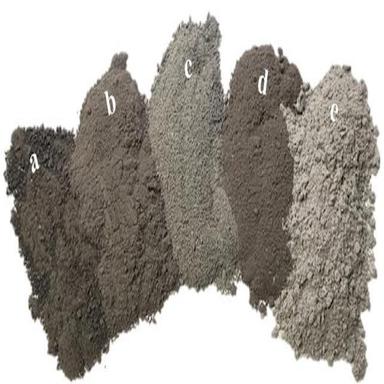
The five lunar regolith simulants that underwent detailed characterization: a) JSC-1A – Mare, b) JSC-2A – Mare, c) EAC-1A – Mare, d) OPRL2N – Mare, and e) OPRH2N – Highlands.